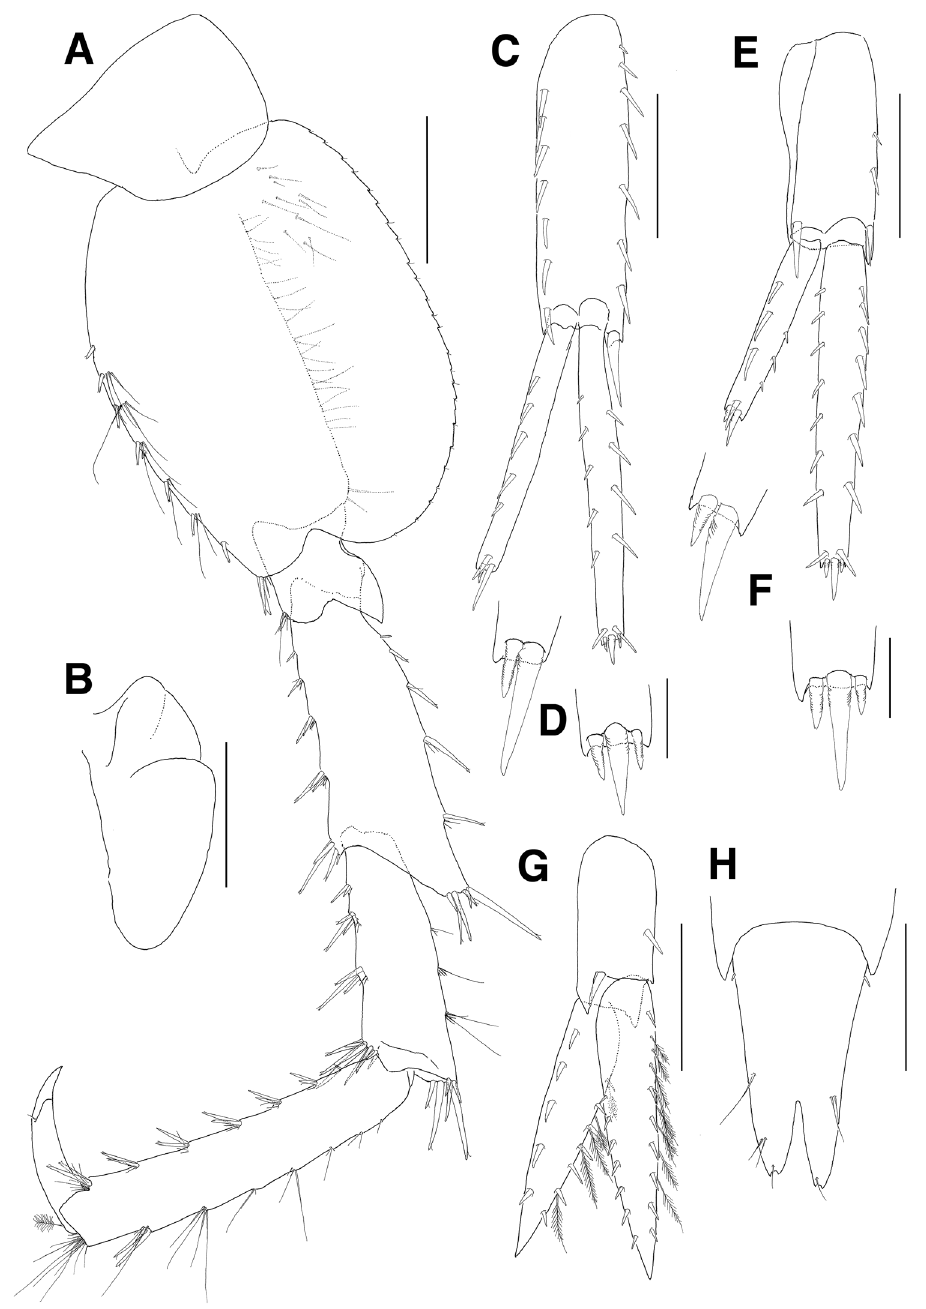
Figure 5. Eusiroides pilopalpus sp. n., holotype. A Pereopod 7 B Coxal gill of pereopod 7 C Uropod 1 D Apices of rami on uropod 1 E Uropod 2 F Apices of rami on uropod 2 G Uropod 3 H Telson. Scale bars 0.1 mm ( D, F ), 0.5 mm ( A–C, E, G, H